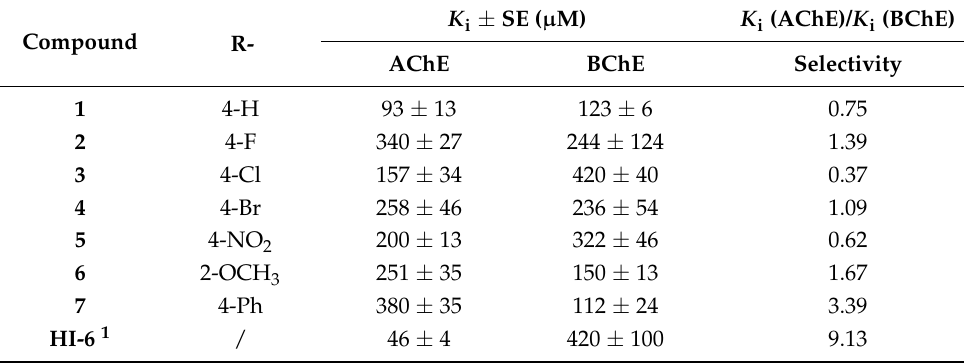
Table 2. Reversible inhibition of AChE and BChE by pyridoxal dioximes and their binding selectivity to AChE or BChE (ratio K i (AChE) over K i (BChE)). Dissociation inhibition constants ( K i ± standard error) were determined from at least three